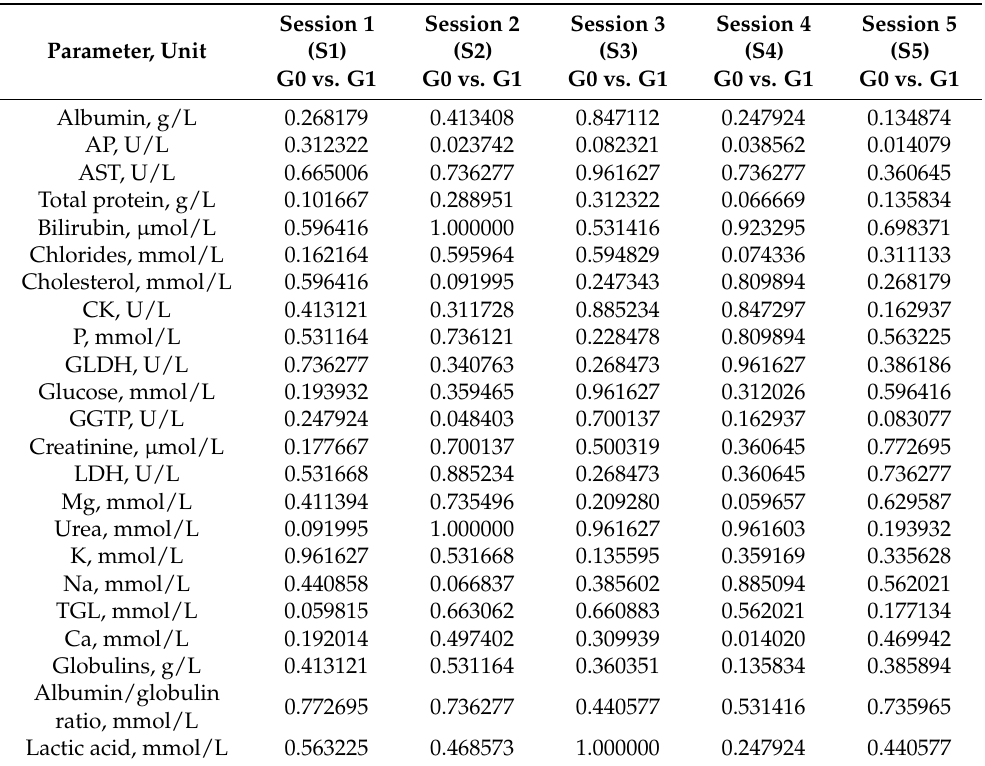
Table 3. p -Value representing differences between supplemented (G1) and control group (G0) for biochemical analysis.